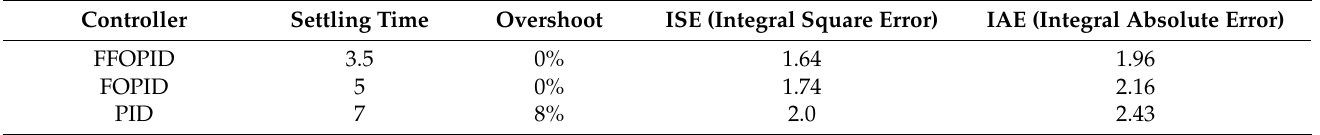
Table 3. Controllers’ performance